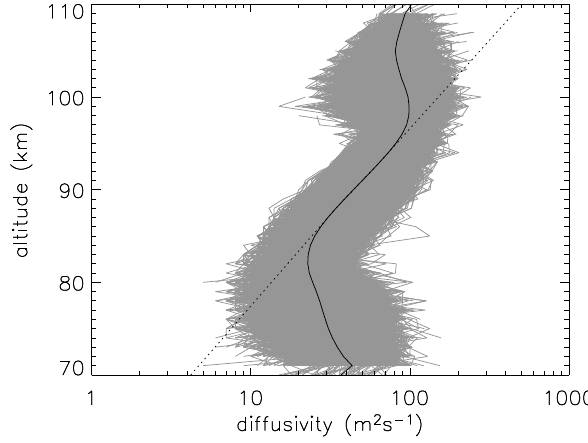
Fig. 1. Diffusion coefficients delivered by NTMR. Every available 30-minute average profile from 1 January to 30 June 2004 has been superimposed (grey lines) and then averaged to obtain a 6-month average (solid black line). The peak meteor trail echo occurrence height is at ∼ 90km. Departures from the anticipated exponen- tial increase with height of molecular diffusion (e.g. dotted black line) are discussed by Dyrud et al. (2001) above ∼ 95km, and by Hall (2002) below ∼ 85km.